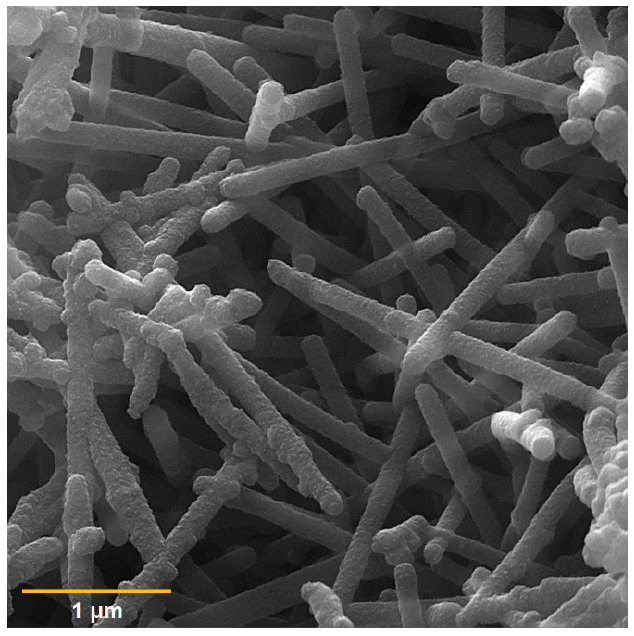
Figure 1. FE-SEM image of the PPy NTs. The FT-IR spectrum of the PPy NTs ranged from 400 to 4000 cm − 1 (Figure 2). The peaks at 1552 and 1450 cm − 1 can be related to symmetric and asymmetric polypyrrole ring stretching bonds, sequentially. Moreover, the peak at 1038, 1333, 1110, and 1603 cm − 1 corresponds to C-H deformation vibrations, C-N stretching vibrations, C-C stretching, and C=C stretching, sequentially. A broad peak at 3446 cm − 1 can also be related to the N-H stretching vibrations of the pyrrole ring. The successful PPy polymer formation is evident based on the FT-IR patterns